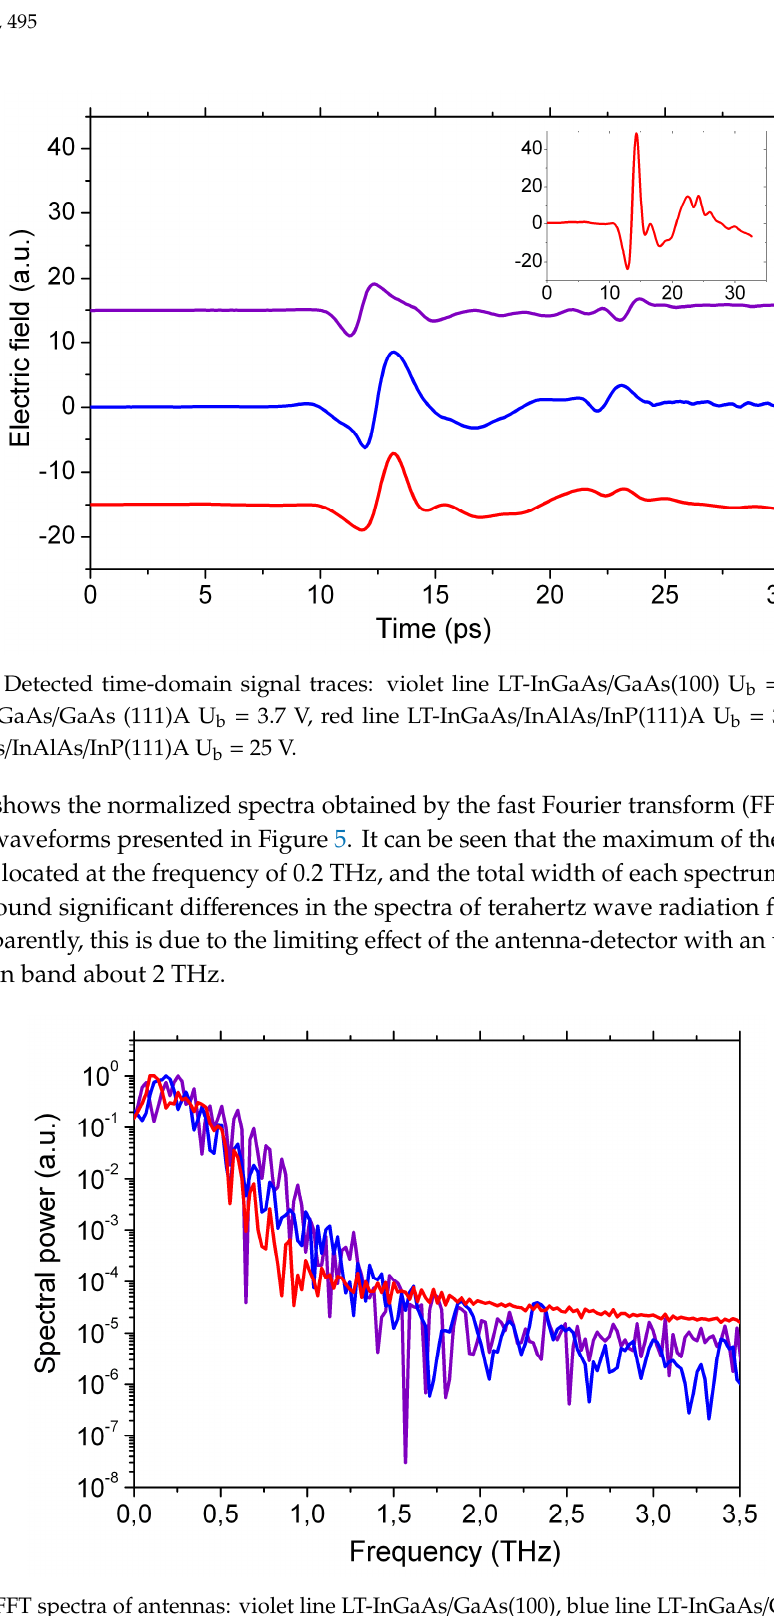
Figure 6. FFT spectra of antennas: violet line LT-InGaAs/GaAs(100), blue line LT-InGaAs/GaAs (111)A, red line LT-InGaAs/InAlAs/InP (111)A.